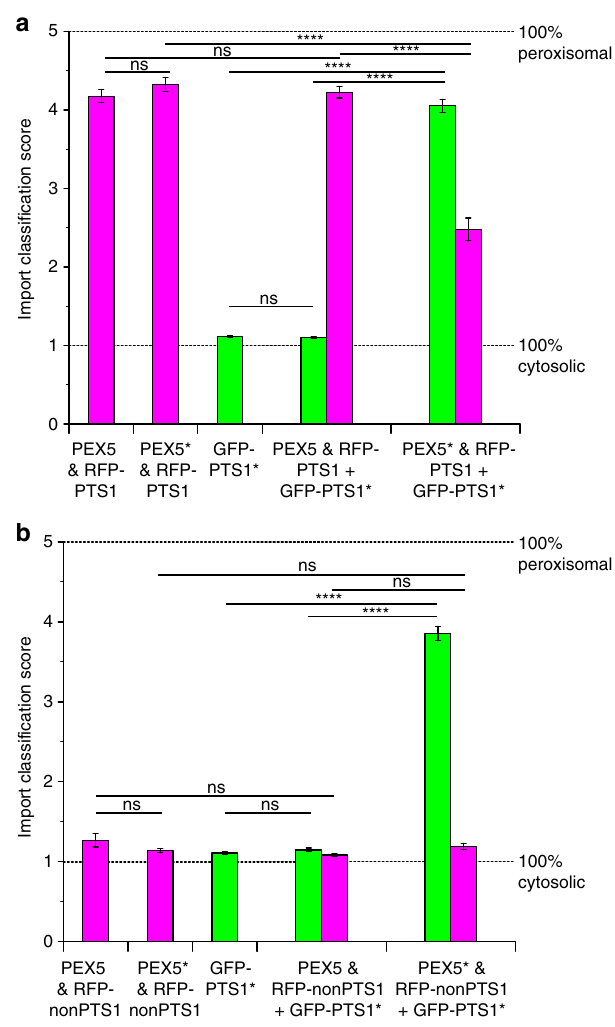
Fig. 4 Quantitative analysis of peroxisome protein import. a , b Transient expression of constructs in P. patens cells. a RFP-PTS1 & PEX5, RFP-PTS1 & PEX5*, b RFP-nonPTS1 & PEX5, or RFP-nonPTS1 & PEX5*, all with and without GFP-PTS1*. Signi fi cant peroxisomal import of GFP-PTS1* was observed when PEX5* was expressed in P. patens , regardless of which RFP reporter was present. No such increase was seen in the absence of